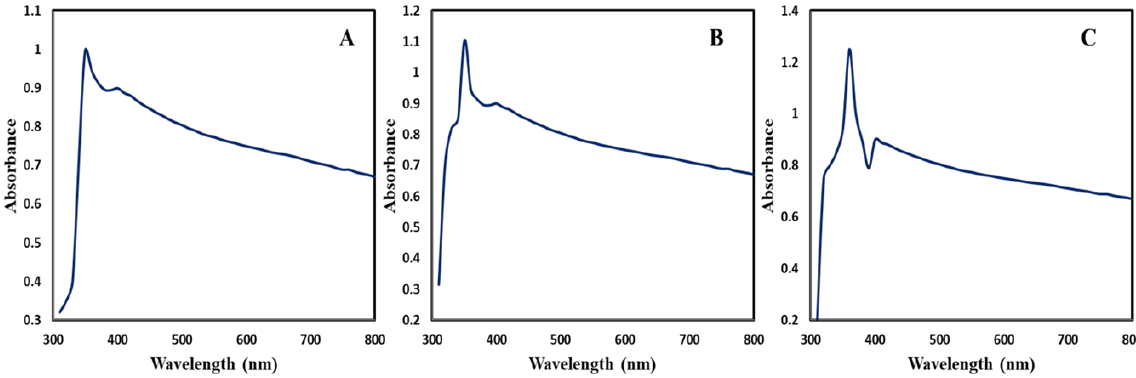
Figure 1. UV-Vis spectra of ZnONPs ( A ) CE-ZnONPs ( B ) CE-UV-A-ZnONPs ( C ) CE-UV-C-ZnONPs.